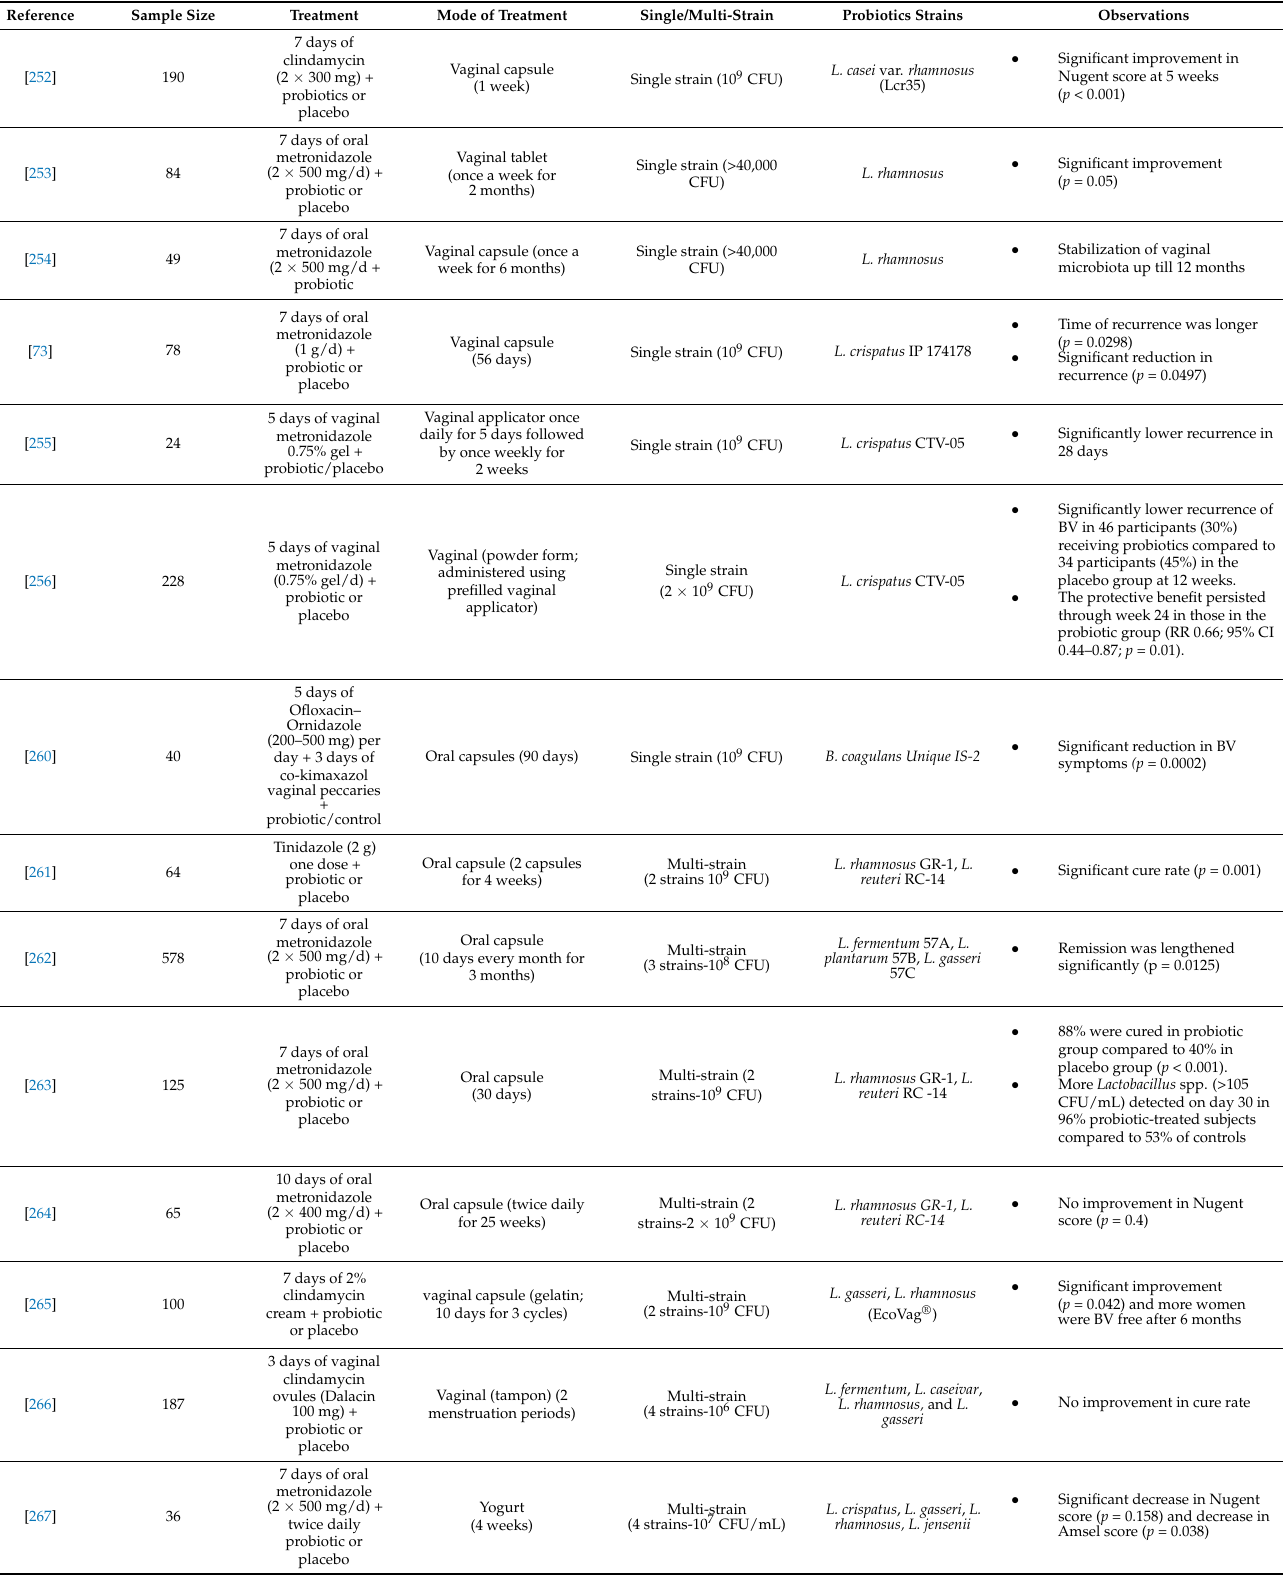
Table 4. Studies reporting the use of probiotics along with antibiotics to treat BV (Randomized control trials).